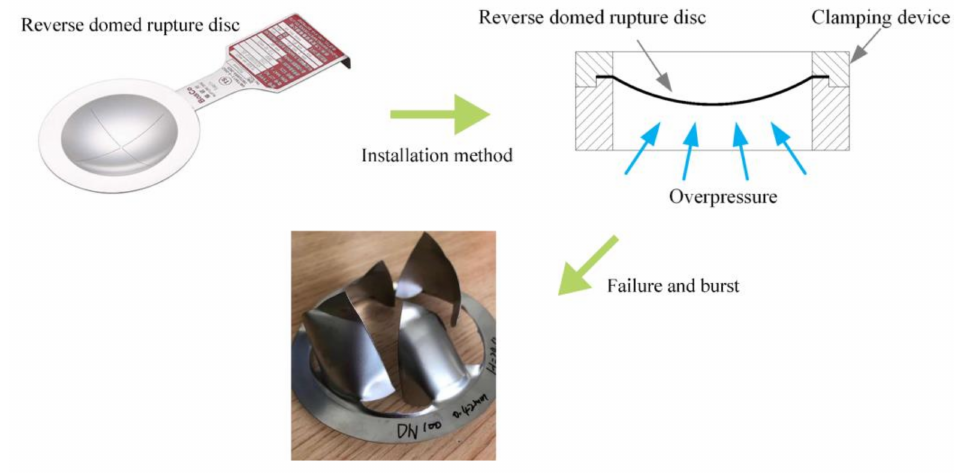
Figure 1. The form and installation method of the rupture disc in the study.